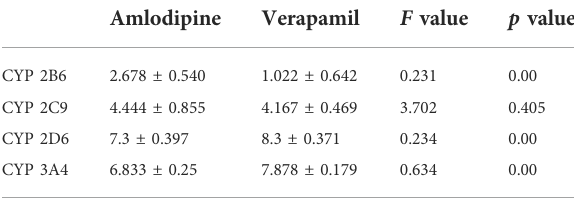
TABLE 3 The af fi nity of amlodipine and verapamil with CYP450 enzymes (mean ± SD, n =